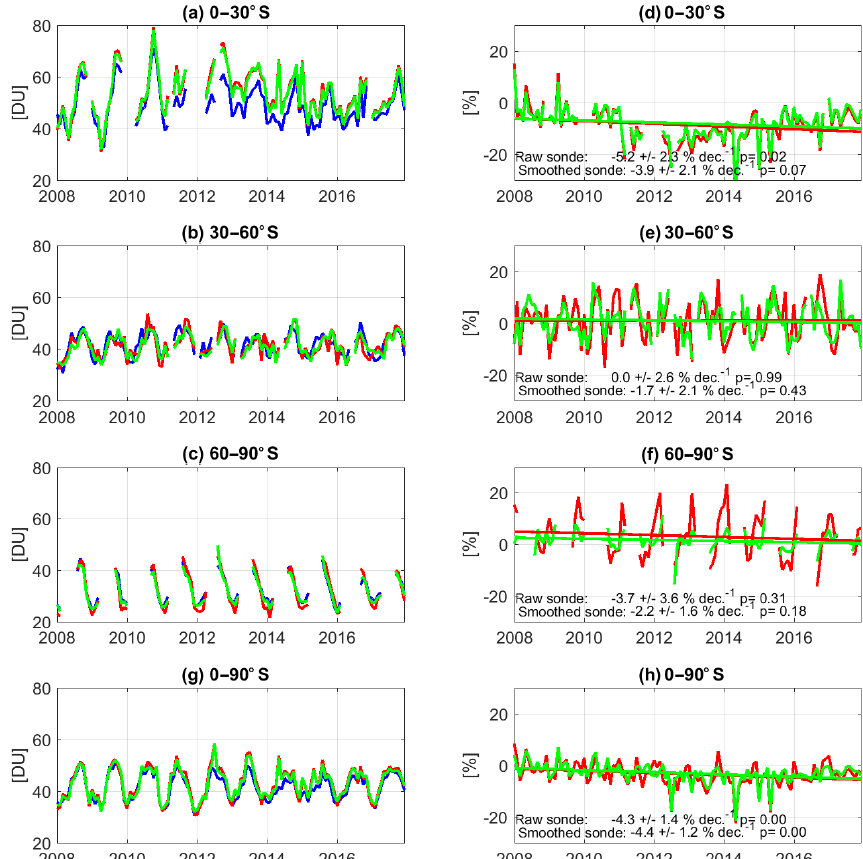
Figure 12. Same as Fig. 9 for SOFRID-O3 v3.5 in the Southern Hemisphere.